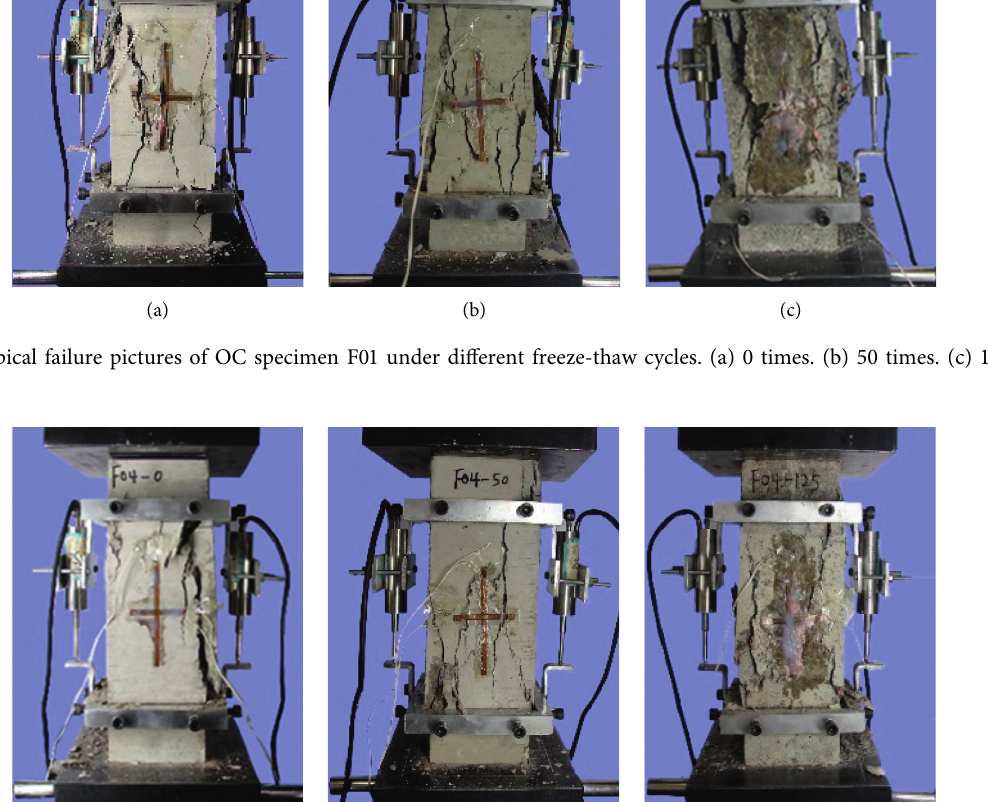
Figure 8: Typical failure pictures of DSC specimen F04 under different freeze-thaw cycles. (a) 0 times. (b) 50 times. (c) 125 times. modulus of DSC with 50% DSRR decreased by 5.1%, 21.7%, elastic modulus of OC decreased by 6.5%, 27.5%, 39.2%, 34.8%, 51.4%, and 62.3%. So, for the same freeze-thaw cycles, 57.3%, and 69.6% under the freeze-thaw cycles of 25, 50, 75, the decrease in elastic modulus of OC was higher than that of 100, and 125 times, respectively. In comparison with elastic DSC with 50% DSRR. At the same time, the elastic modulus modulus of unfrozen DSC with 50% DSRR, the elastic